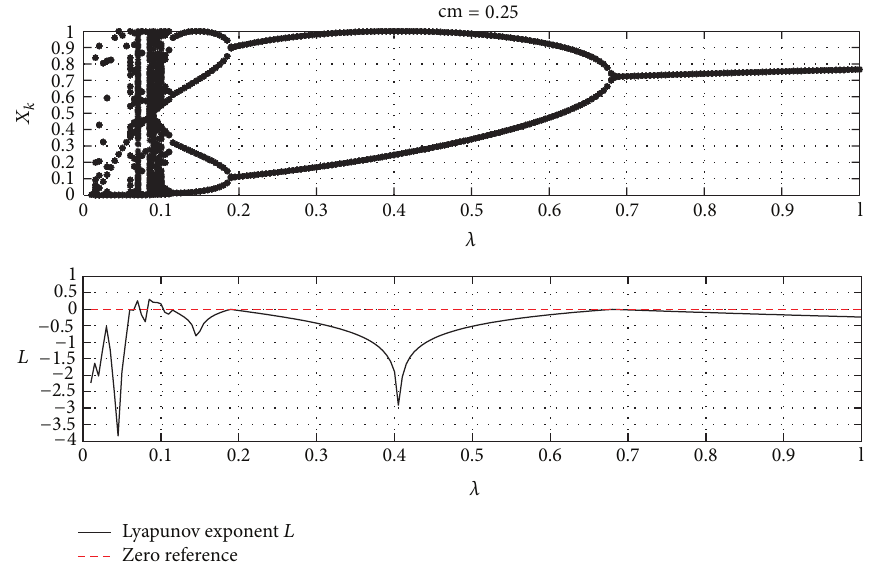
Figure 6: A bifurcation diagram and Lyapunov exponent setting cm = 0.25 .